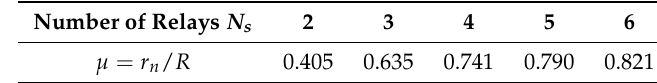
Table 1. Asymptotic optimal relay